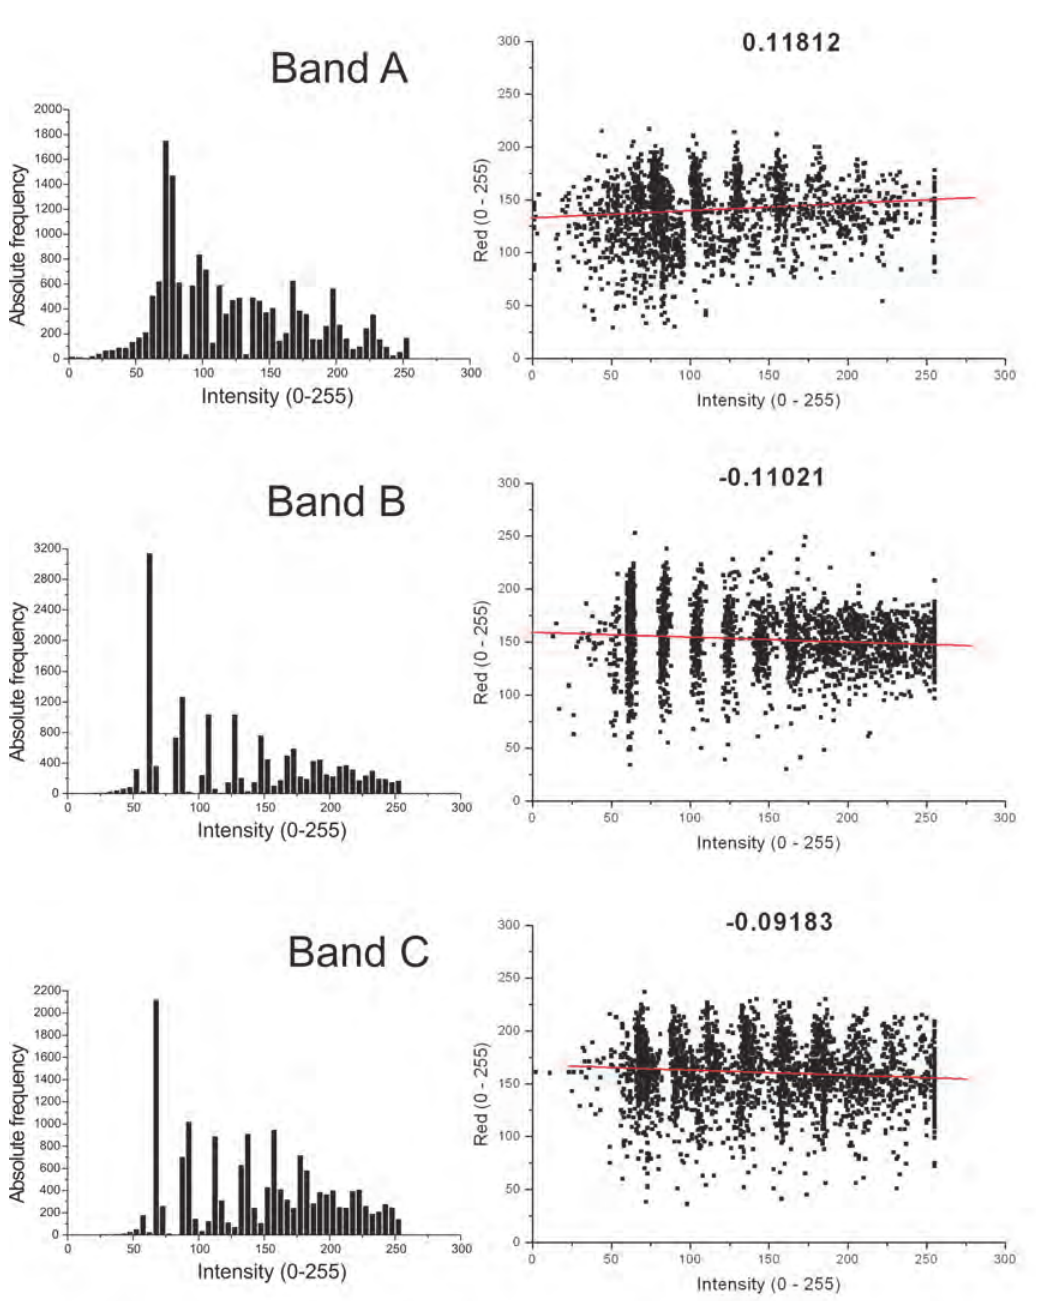
Fig. 8. Statistical distribution and data correlation of 3 data sub-sets. Also in these cases, despite larger noise, peaks are well